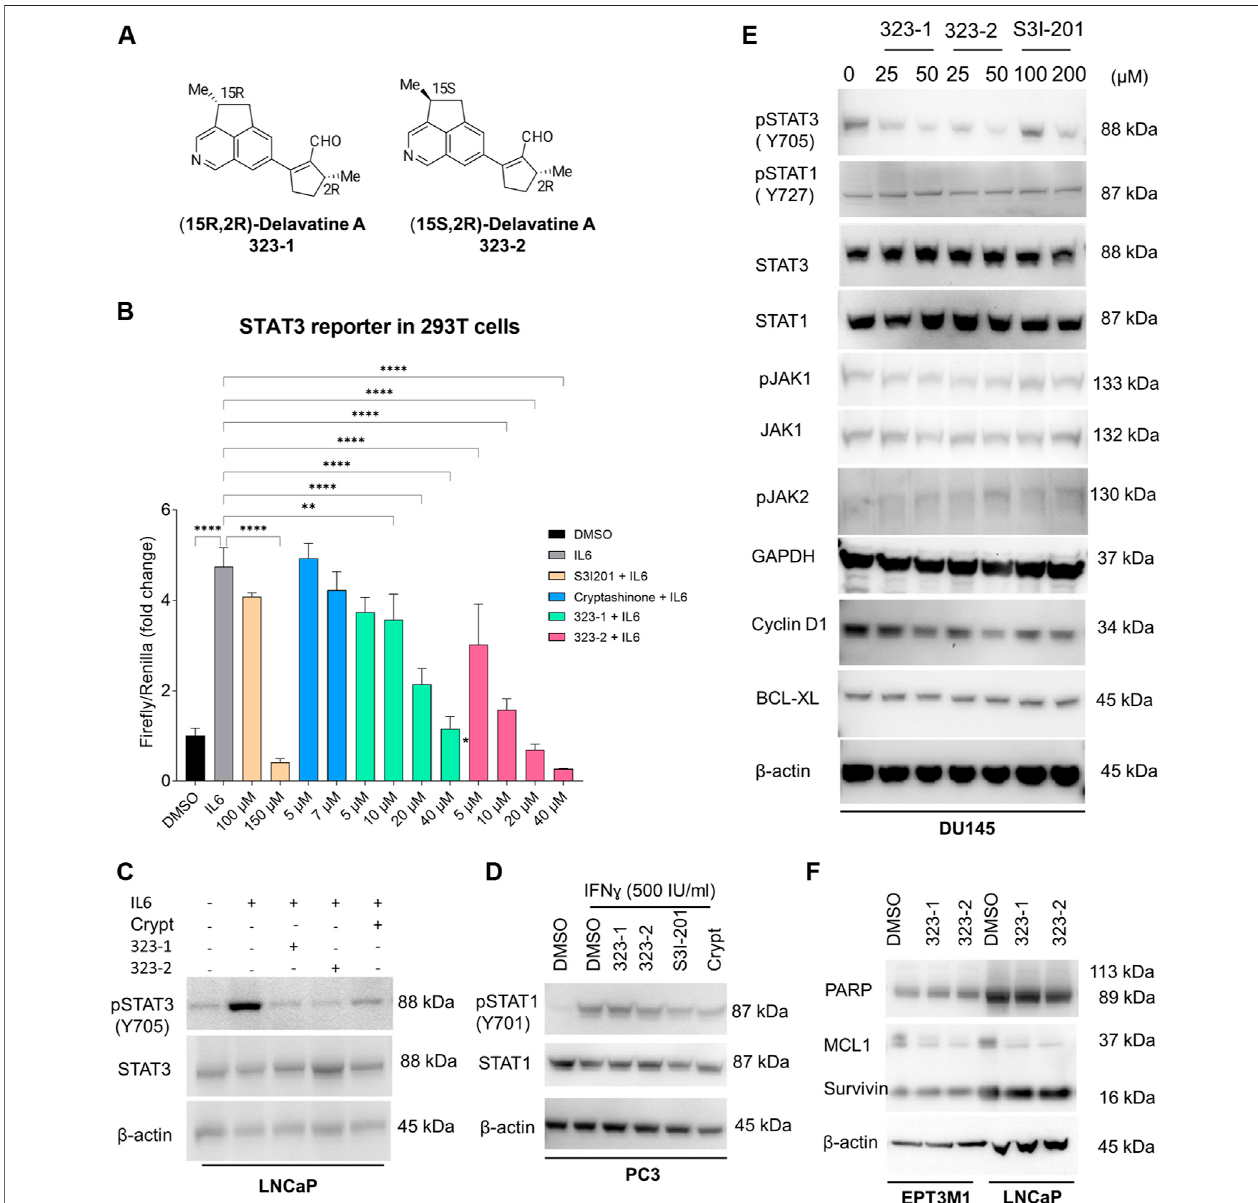
FIGURE 1 | Compounds 323 – 1 and 323 – 2 target the IL-6/STAT3 pathway. (A) Chemical structure and nomenclature of compounds 323 – 1 and 323 – 2. (B) HEK 293T cells transfected with the STAT3 luciferase reporter were treated with different doses, as indicated of 323 – 1 or 323 – 2, S3I-201, or cryptotanshinone (Crypt) in the presence of 20 ng/ml IL-6 for 24 h. All data are represented as the average ±s. e.m. ( n = 3).Signi fi cance was analyzed by using one-way ANOVA multiple comparison. * p ≤ 0.05,** p ≤ 0.01,*** p ≤ 0.001,and**** p ≤ 0.0001. (C) LNCaPcellsweretreatedwithDMSO,20 µM323 – 1or323 – 2,or5 µMcryptotanshinonefor24 hbefore treatment with or without 10 ng/ml IL-6 for the last 15 min. (D) PC3 cells were treated with DMSO, 20 µM 323 – 1, 20 µM 323 – 2, 100 µM S3I-201, or 5 µM cryptotanshinonefor24 hbeforetreatmentwithorwithout500IU/mlIFN ɣ forthelast15 min. (E) DU145cellsweretreatedwithindicateddosesof323 – 1,323 –